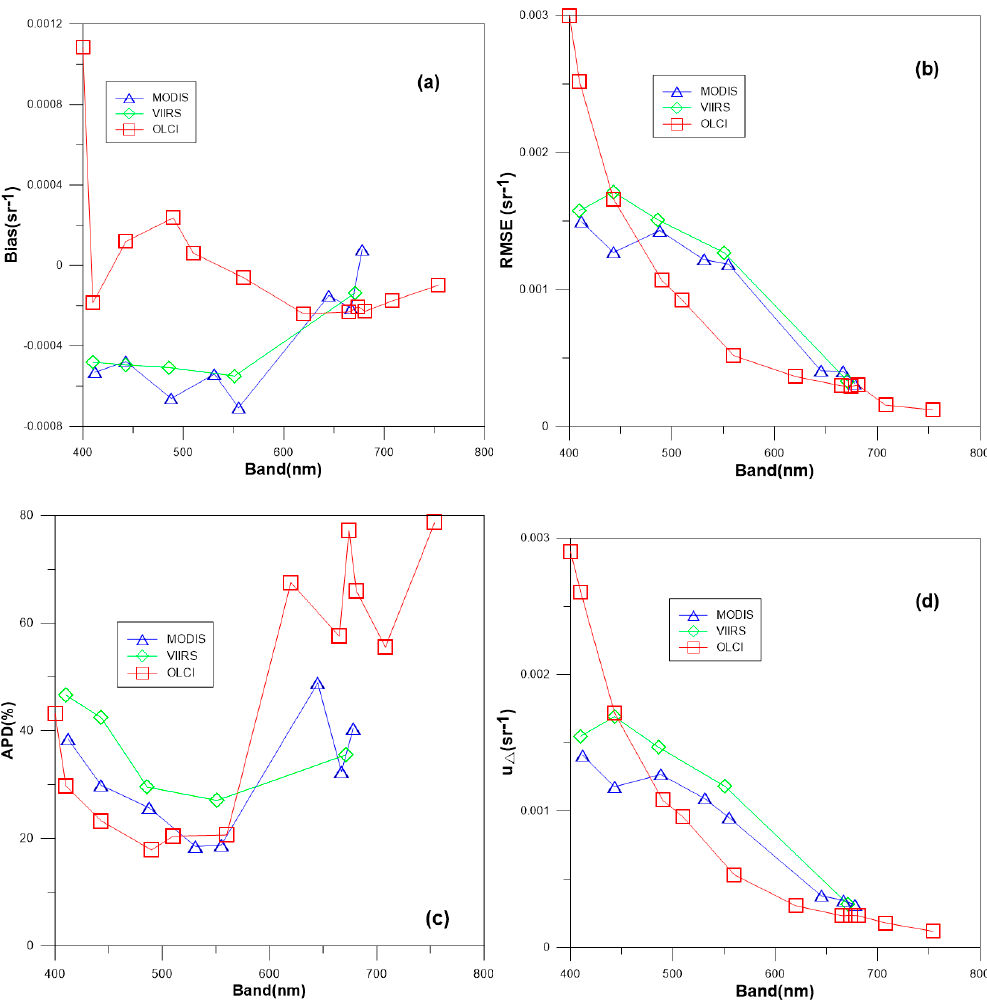
Figure 8. Variation of bias ( a ), RMSE ( b ), APD ( c ), and 𝑢 ∆ ( d ) of OLCI, MODIS, and VIIRS with the wavelengths. Remote Sens. 2019 , 8 , x FOR PEER REVIEW